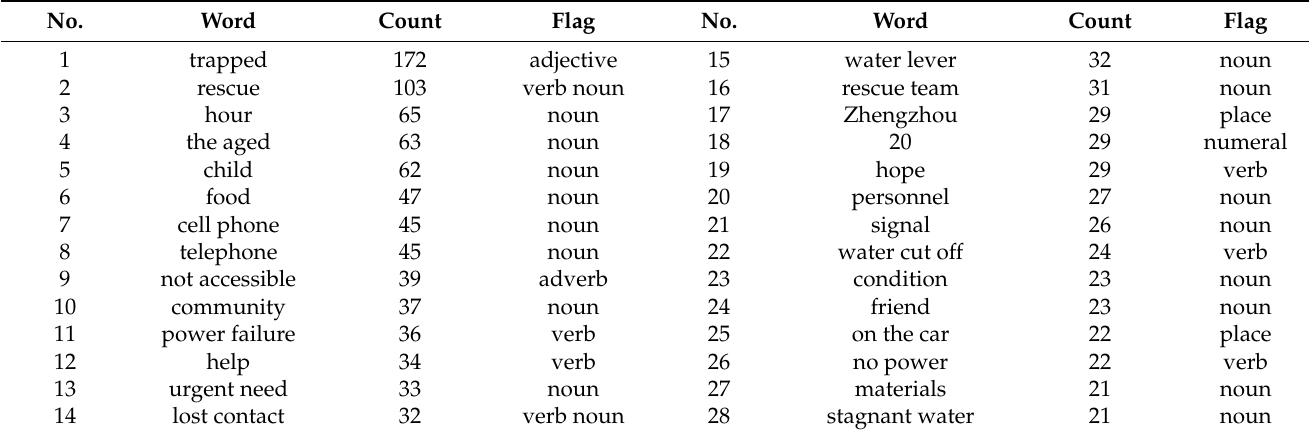
Table 3. Keywords counted more than 20 times in SOS